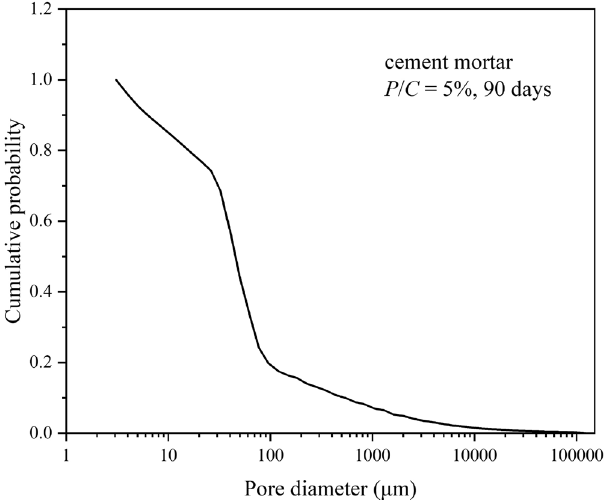
Figure 6. Cumulative pore volumes in epoxy latex-modified mortars hydrated in P/C = 5% for 90 days.